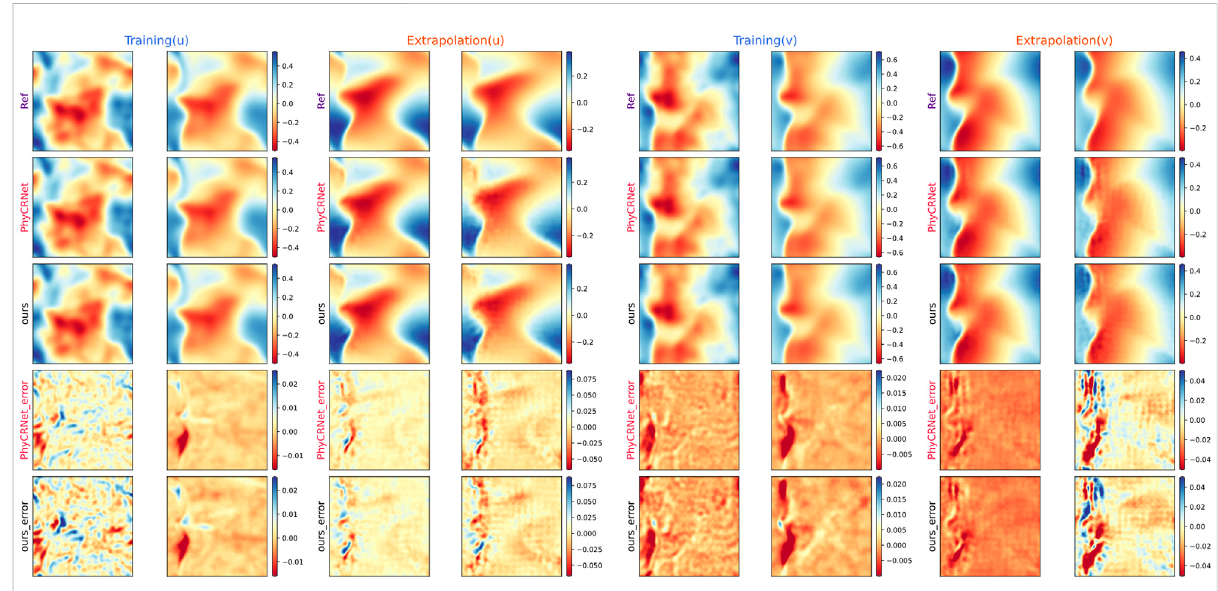
FIGURE 2 The results of Fourier fi lter-based PhyCRNet and PhyCRNet network solving the two-dimensional viscous Burger ’ s equation. Four representative moments are selected for comparison as training (t = 0.1, 0.3 s) and extrapolation (t = 0.6,0.8 s), and theerrors across theinterval are compared. The sub fi gures from top to bottom are reference solutions, predictions by PhyCRNet and ours, and errors of PhyCRNet and ours,